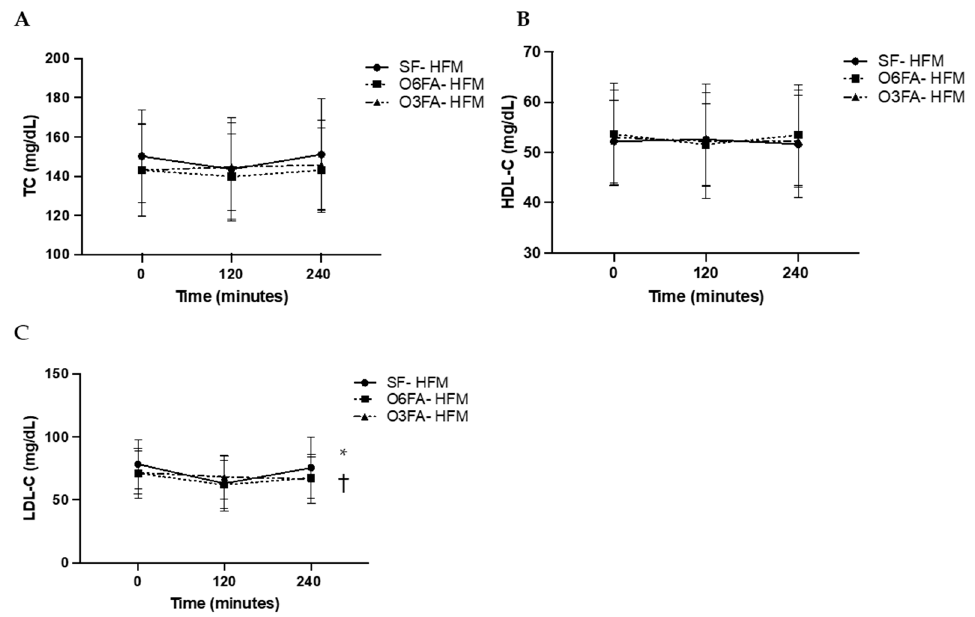
Figure 3. ( A – C ). Postprandial metabolic responses. Metabolic responses in the three smoothie conditions are displayed as a mean ± SE for baseline, 2 h (120 min), and 4 h (240 min). TC ( A ), HDL-C ( B ), and LDL-C ( C ) are displayed with the SF-HFM in shaded black circle, the O6FA-HFM in black squares, and the O3FA-HFM in black triangles. * Indicates significance across time points, and † indicates significance as an interaction between smoothie type and time